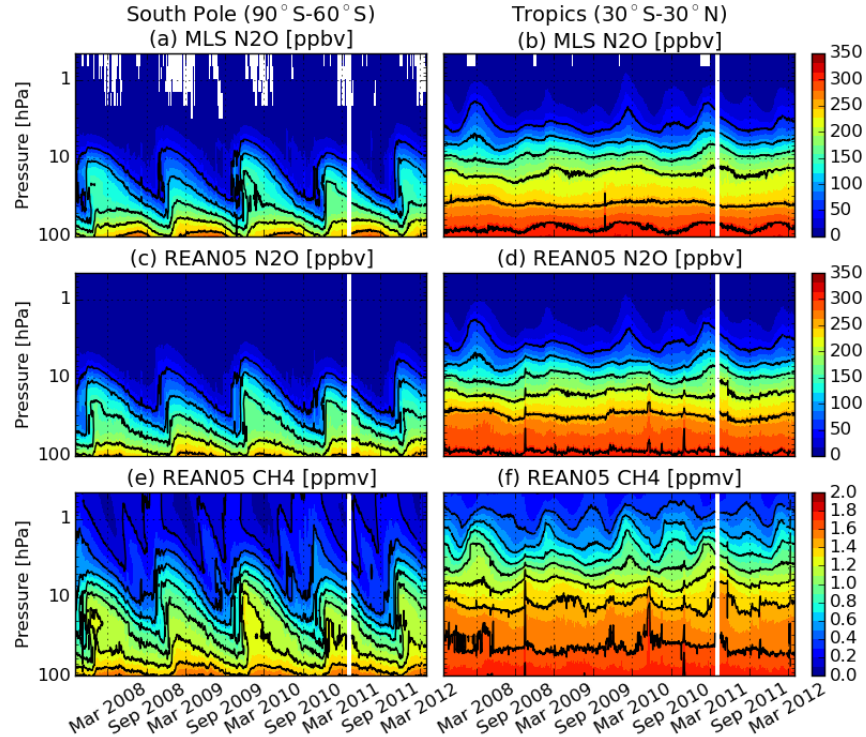
Figure 10. Top row: time series of daily average MLS N 2 O between 90–60 ◦ S (left) and 30 ◦ S–30 ◦ N (right) for the period October– April 2012. Middle row: as first row but for REAN N 2 O. Bottom row: as first row but for REAN CH 4